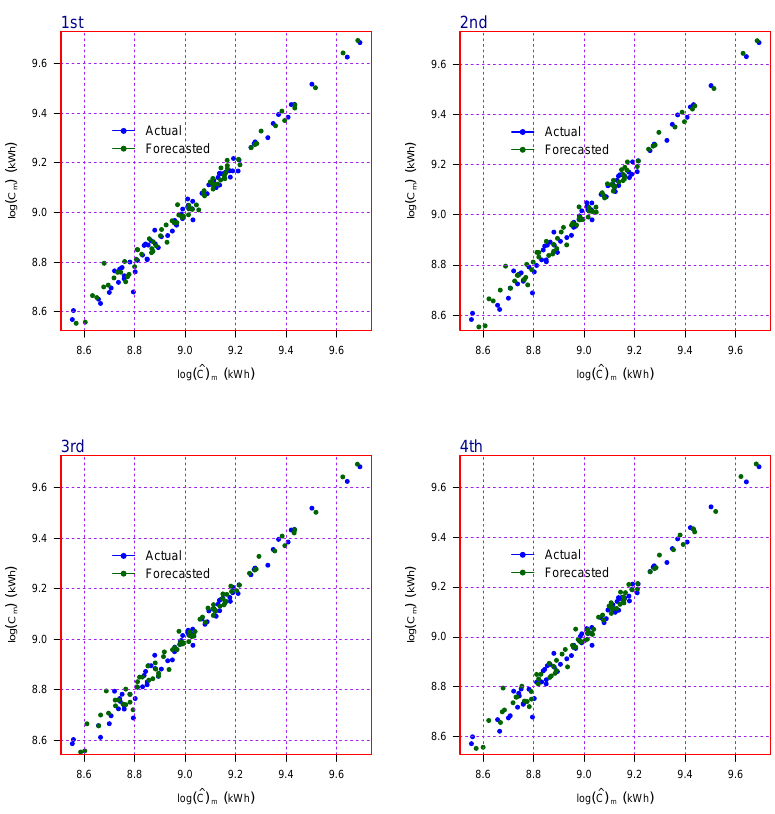
Figure 5. Scatter plot for the electricity consumption forecasting models along with the correlation coefficient (CORR), c DH b c ( 1st ), c DH a c ( 2nd ), a DH a c ( 3rd ), and a DH b c ( 4th ).